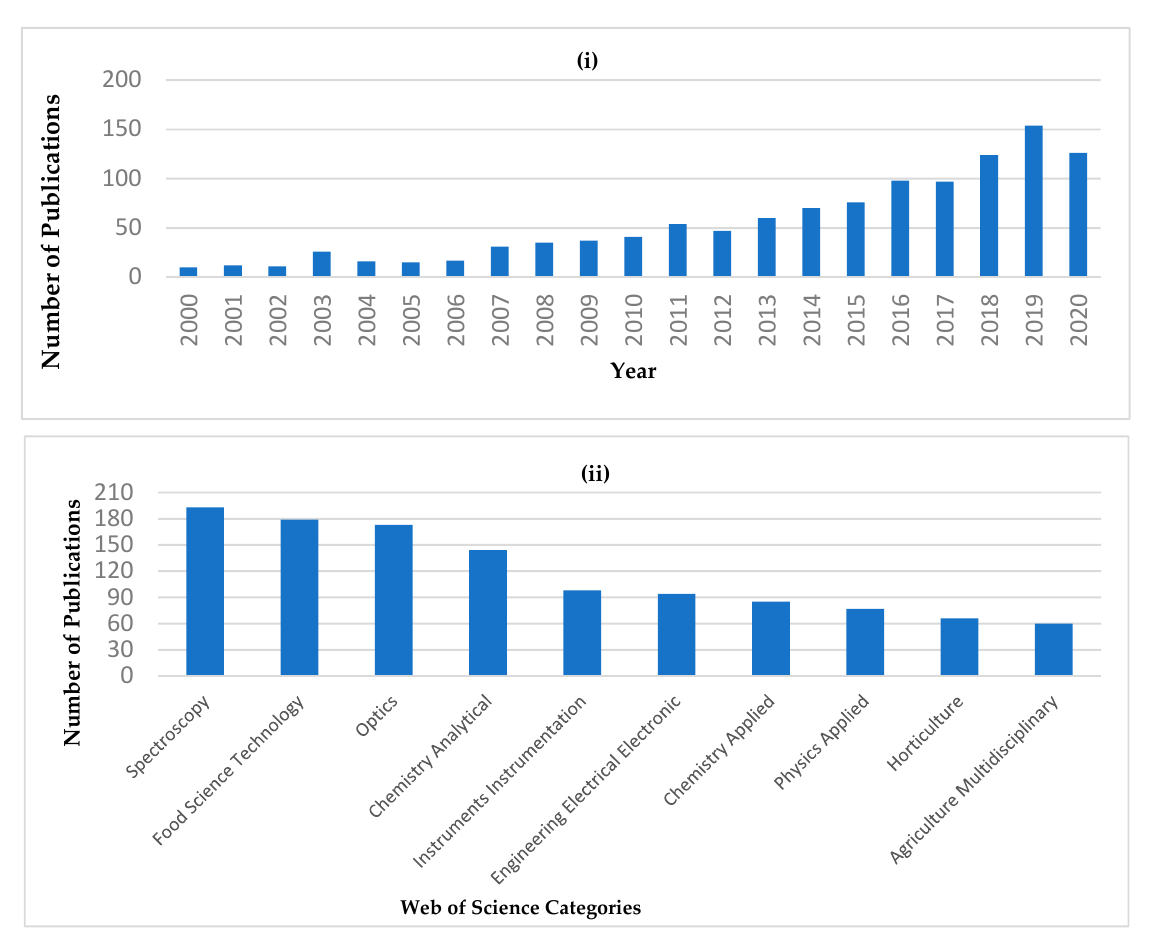
Figure 1. Publication records from the Web of Science database, using the search words “NIR, portable” or “NIR, handheld” or “NIR, hand-held” from 2000 to 2020 (Data accessed on 29 October 2020). ( i ) Number of publications in each year. ( ii ) Number of publications for the first ten Web of Science categories.